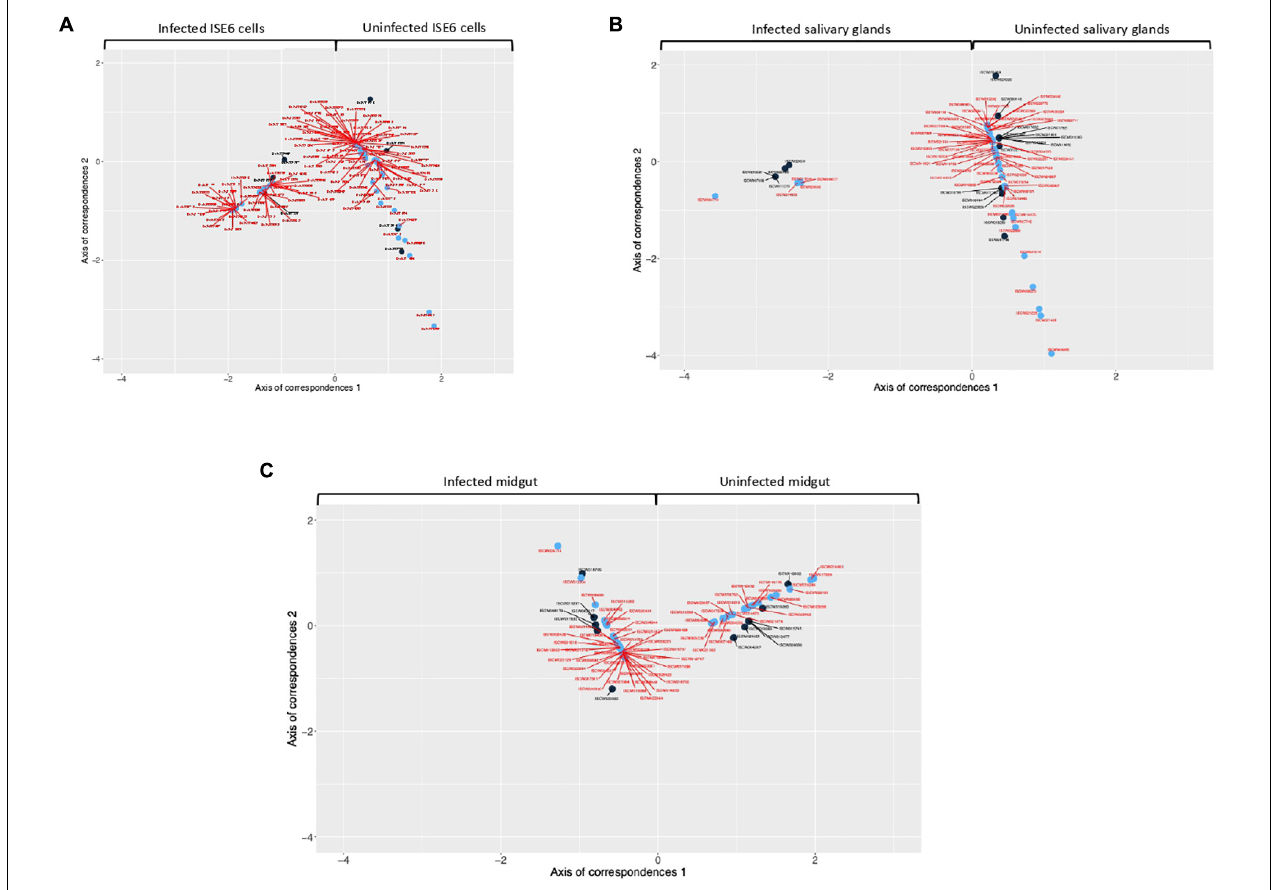
FIGURE 2 | Co-correspondence analysis (CoCA) of TF and TG in uninfected and A. phagocytophilum- infected samples. CoCA was conducted in I. scapularis (A) ISE6 cells, (B) salivary glands and (C) midgut. The charts show the position of TF (black symbol and label) and TG (blue symbol and red label) after the CoCA of the indexes of centrality. The TF and associated TG with highest values of centrality in the network of infected cells appear together at negative values of the Axis 1 ( n = 4, 4, and 9 in ISE6 cells, salivary glands and midgut, respectively). The TF and the associated TG with highest values of centrality in the network of uninfected cells appear together at positive values of the Axis 1 ( n = 4, 17, and 8 in ISE6 cells, salivary glands and midgut, respectively). High-resolution images are shown in Supplementary Figures 2A–C .